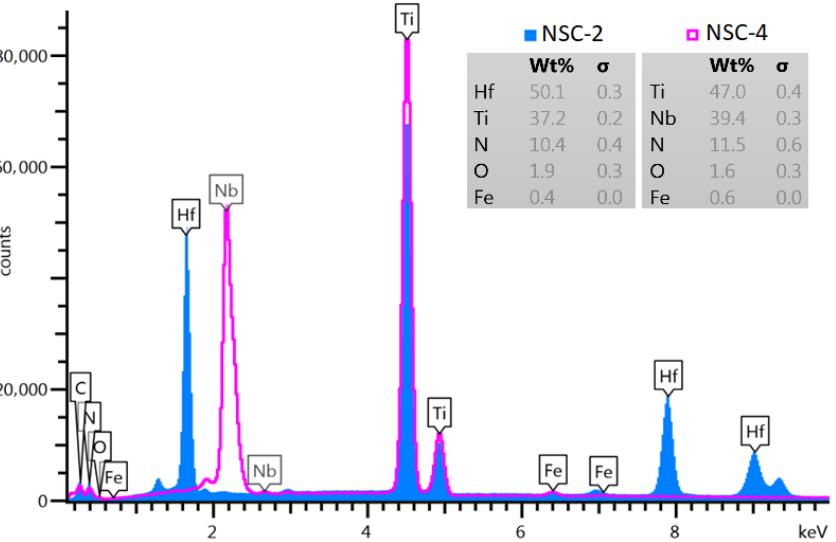
Figure 3. SEM-EDS elemental microanalysis of the NSC samples doped by the atomic elements of Hf (NSC-2) and Nb (NSC-4). The elemental composition was identical for samples doped with the same elements ((NSC-1, NSC-2, and NSC-3) and (NSC-4, NSC-5, and NSC-6)).